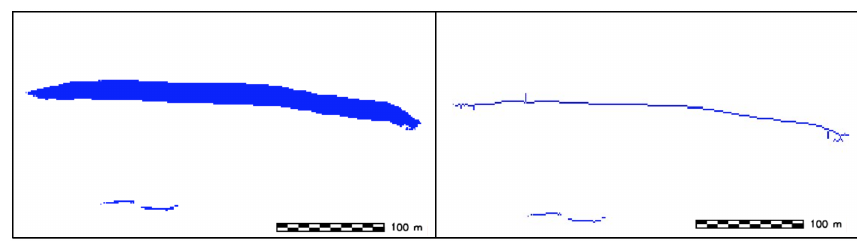
Figure 8. SWC thinning.